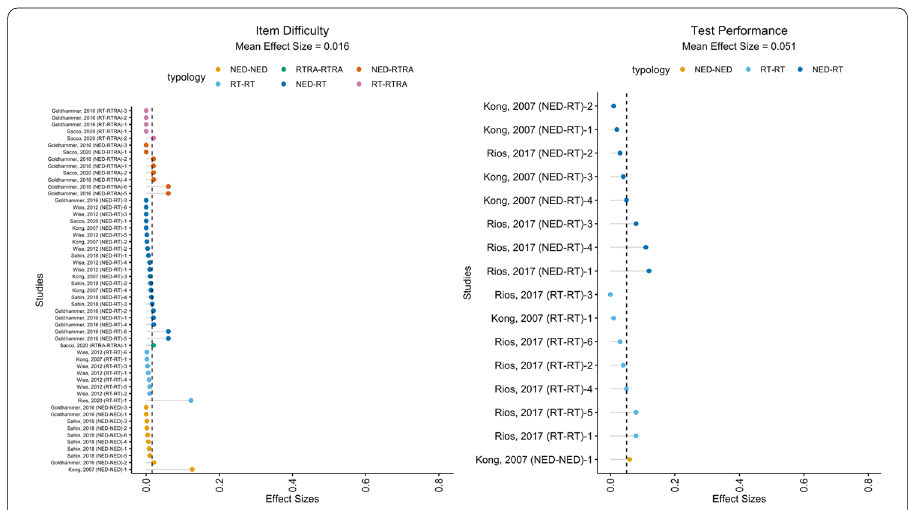
Fig. 4 Effect size based on RT typology pairing for measurement property and performance